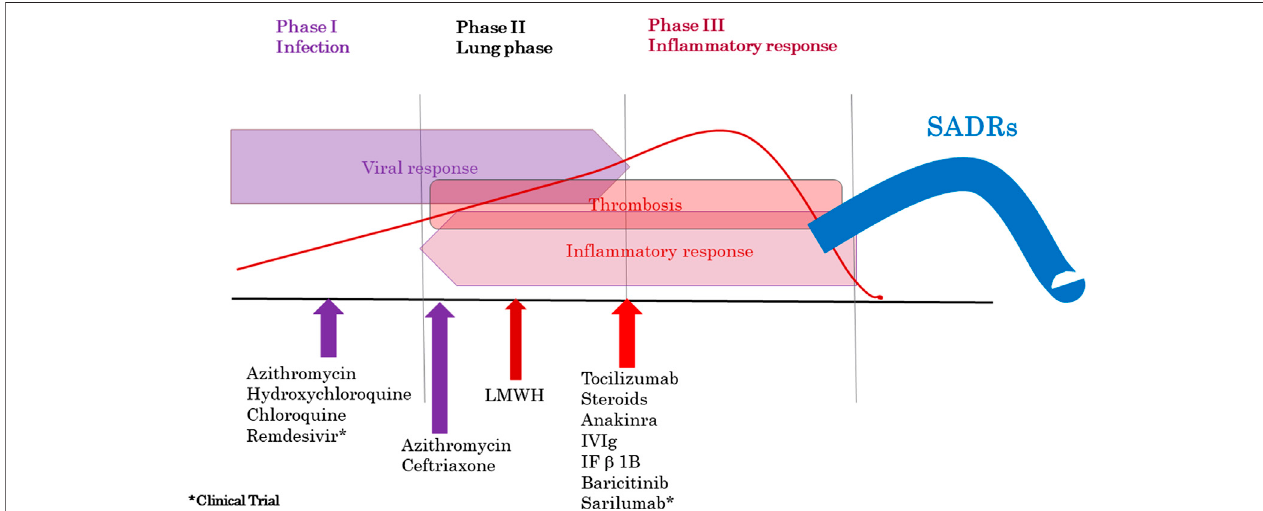
FIGURE 2 | COVID-19 infection stages and treatments employed. Abbreviations: LMWH, low-molecular-weight heparin; Ig, immunoglobulin; IV Ig, intravenous immunoglobulin; IF β -1b, interferon beta-1b; SADRs, serious adverse drug